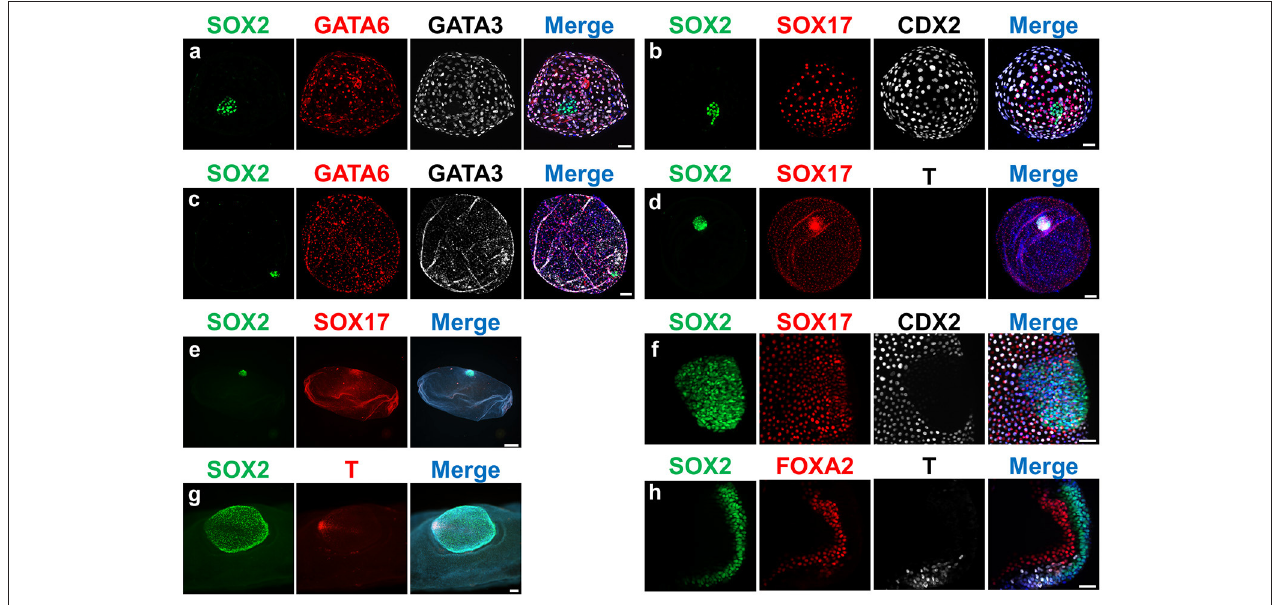
FIGURE 2 | Expression of lineage-specific markers in ovine embryos at different developmental stages. Fluorescence images of embryos stained for SOX2 (epiblast); SOX17/GATA6/FOXA2 (hypoblast/endoderm); CDX2/GATA3 (trophectoderm); T (mesoderm). Nuclei were counterstained with DAPI (merge). (a,b) D9 Hatched blastocysts; (c,d) : D11 Spherical embryos; (e) D13 Tubular embryo; (f) D13 ED without Rauber’s layer; (g) gastrulating ED; (h) section of a gastrulating ED. Scale bars = 50 µ m for (a,b,f,h) ; 100 µ m for (c,d,g) ; 500 µ m for panel (e) .